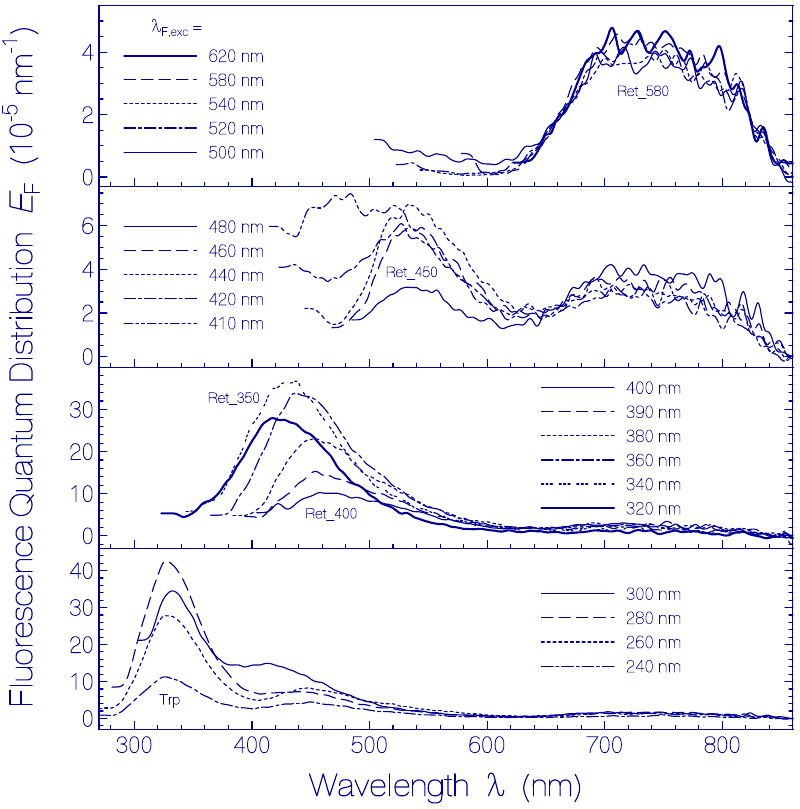
Figure 6. Fluorescence emission quantum distributions E F ( λ ) of QuasAr1 in pH 8 Tris buffer stored at 2.5 °C for a duration of 80 days. The fluorescence excitation wavelengths λ F,exc are listed in the legends.